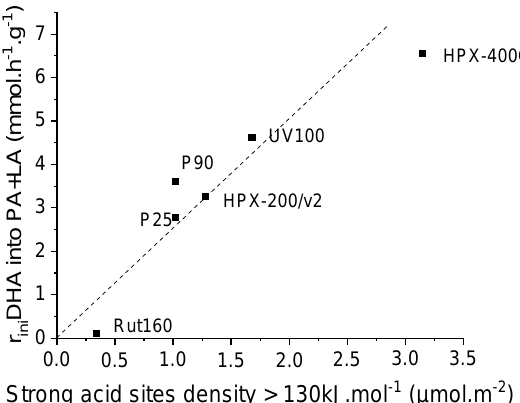
Figure 10. Linear increase of the initial rates of pyruvaldehyde and lactic acid formation with TiO 2 ′ s original strong acid sites density (sites with heat of ammonia adsorption > 130 kJ.mol − 1 as determined by calorimetry of ammonia adsorption).